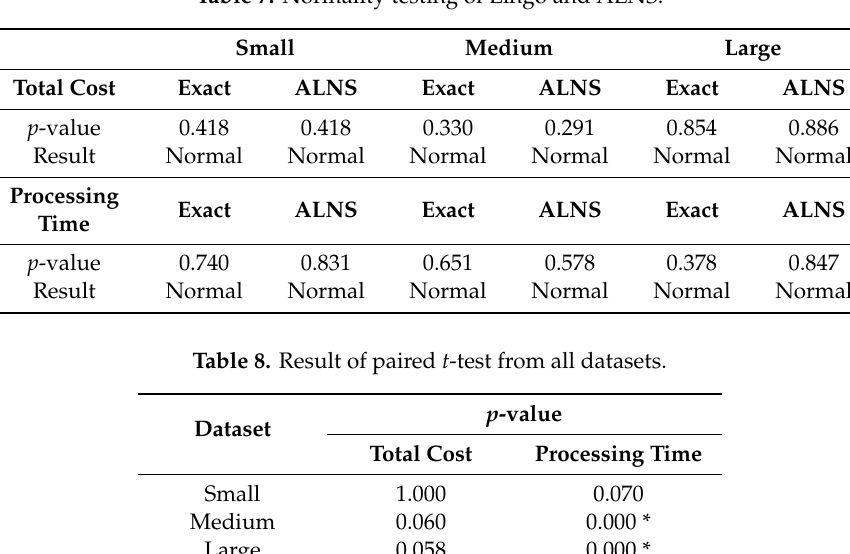
Table 7. Normality testing of Lingo and ALNS.